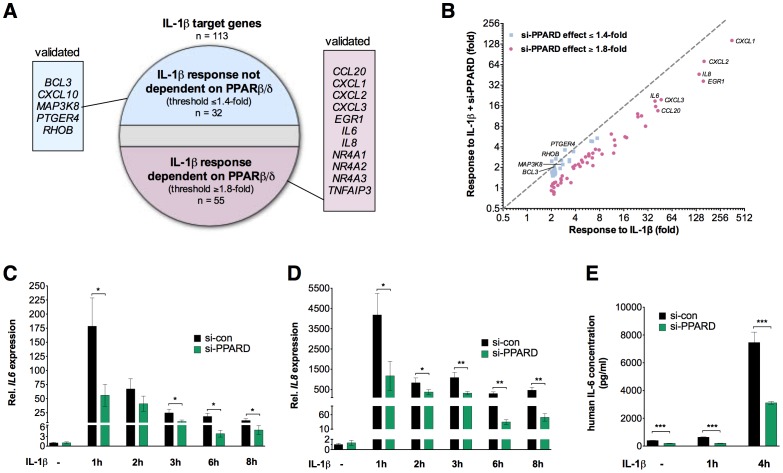
Effect of PPARβ/δ depletion on global transcriptional response to IL-1β.(A) Diagrammatic representation of IL-1β target genes (threshold ≥2-fold; n = 113) showing a reduced induction by IL-1β (threshold ≥1.8-fold; n = 55) or no significant effect on induction (threshold ≤1.4-fold; n = 32) after PPARβ/δ depletion. HeLa cells were treated with control siRNA (si-con) or PPARD-directed siRNA (si-PPARD) followed by IL-1β (10 ng/ml) for 1 h (see Figure S1 for knockdown efficiency). Expression patterns were determined by microarray analyses and genes showing a ≥2-fold regulation were identified (Datasets S1 and S2). The observed regulation was verified by RT-qPCR, as exemplified for the genes listed in the boxed areas and shown in Figures S2 and S3. (B) Scatter plot showing the IL-1β response of individual genes with or without PPARD silencing (microarray data from panel A). The dashed line shows the ideal position of genes theoretically unaffected by si-PPARD. Blue data points: effect ≤1.4-fold; red data points: effect ≥1.8-fold. (C), (D) Effect of PPARβ/δ depletion on the time course of the IL-1β-mediated induction of the IL6 (C) and IL8 (D) gene determined by RT-qPCR. (E) Effect of PPARβ/δ depletion on IL-1β-induced IL-6 secretion in HeLa cells determined by ELISA (1 h and 4 h stimulation with IL-1β). Values represent averages ±SD (n = 3). ***, **, *significant difference between si-con and si-PPARD-treated cells (p<0.001, p<0.01, p<0.05 by t-test).